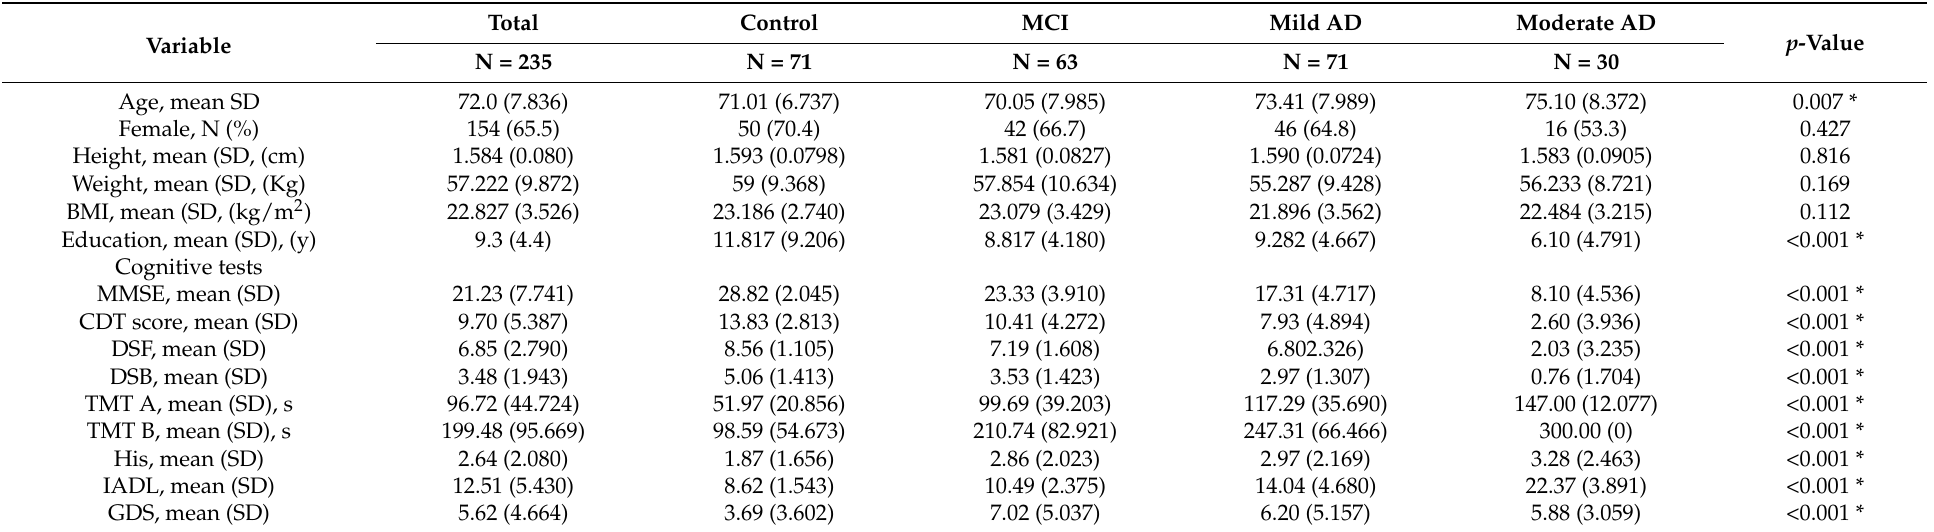
Table 1. Baseline characteristics of participants stratified by disease